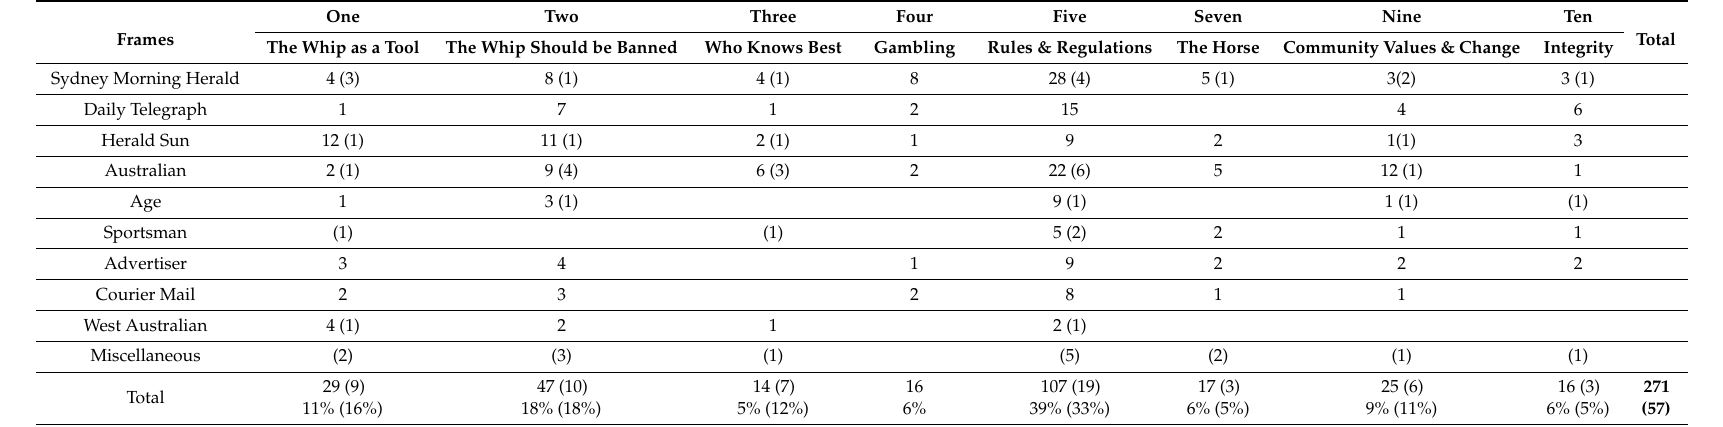
Table 4. Frames in Australia Print Media: 2009 and (August